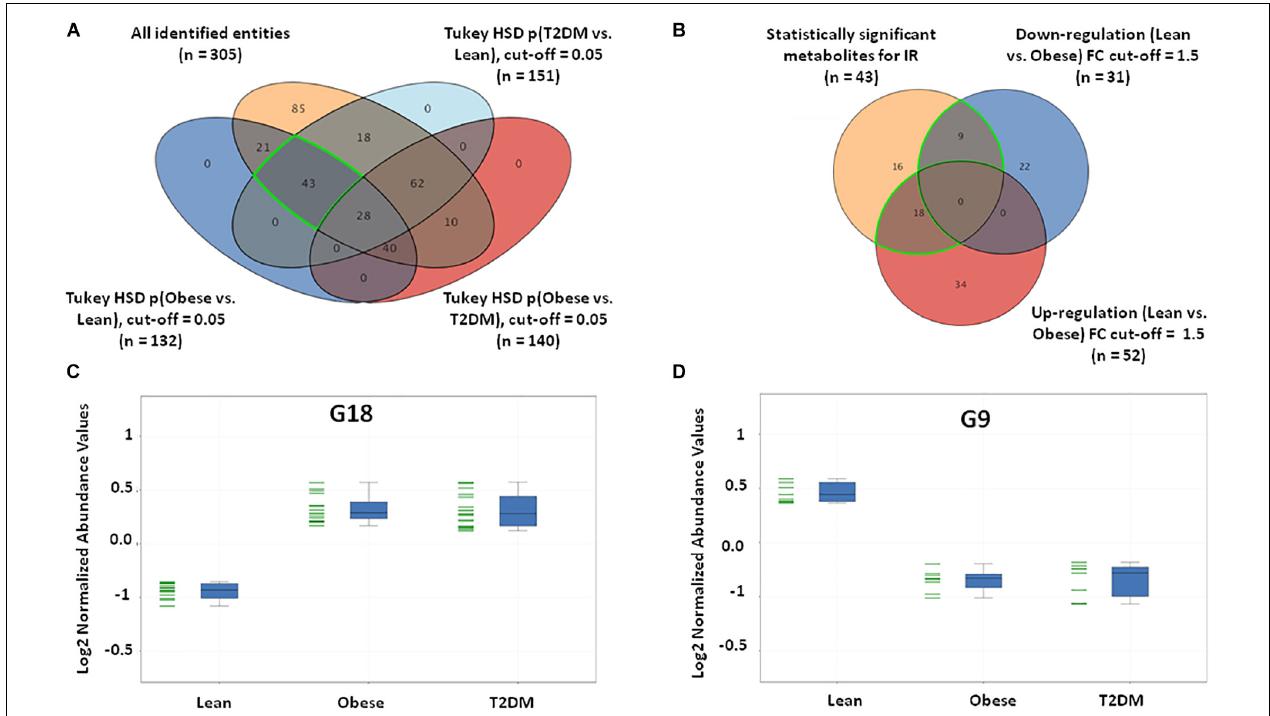
FIGURE 2 | IR metabolic model based on the positively identified features. (A) A Venn diagram showing that out of 3633 detected features, only 305 (˜8%) metabolites were positively identified. 43 (G43) significant metabolites were considered a metabolic pattern for IR, where they were statistically significant between lean vs obese and lean vs T2D, and insignificant between obese vs T2D (FDR-corrected p -value < 0.05). (B) A Venn diagram showing the number of the up- and down-regulated metabolites after fold change analysis (cutoff l.5) on the significant metabolites (G43) (nine and 18 metabolites, respectively). (C) The expression profile of G18 and (D) G9